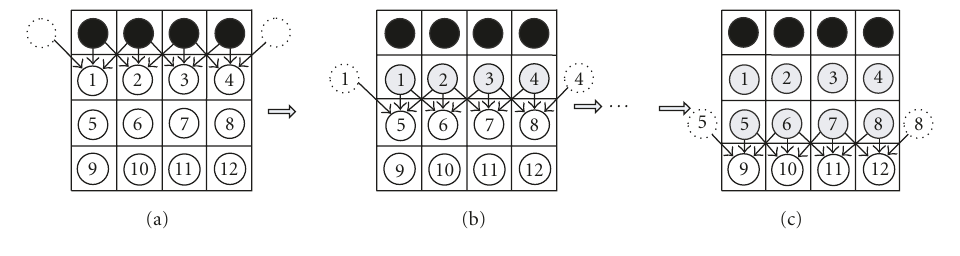
Figure 7: Filtering